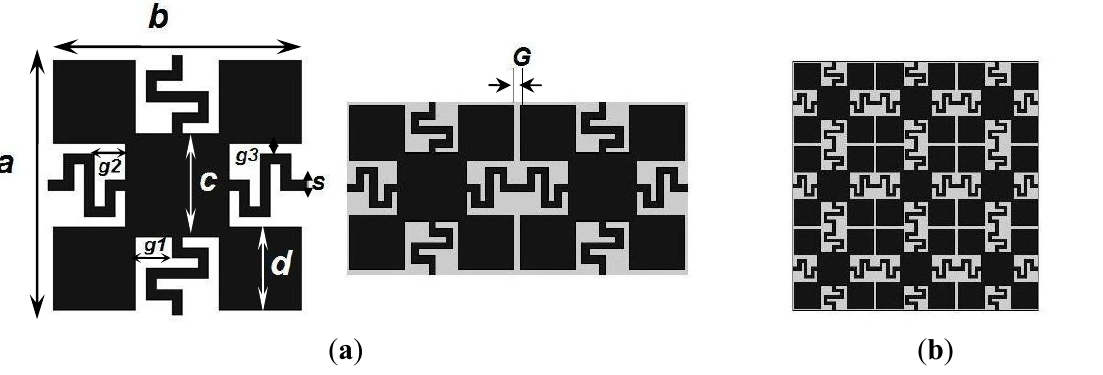
Figure 1. ( a ) Schematic of meander-line bridge high impedance electromagnetic structure (MBHIES) unit cell; ( b ) A 3 × 3 array of proposed